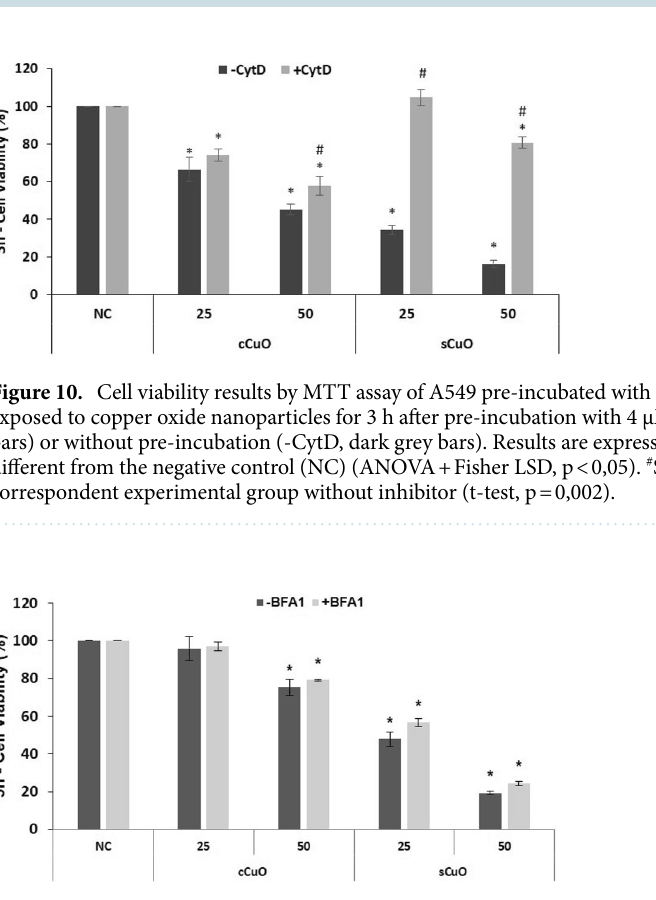
Figure 11. Cell viability results by MTT assay of A549 pre-incubated with a proton-pump inhibitor. Cells were exposed to copper oxide nanoparticles for 3 h after pre-incubation with Bafilomycin A1 (+ BafA1, light grey bars) or without pre-incubation (-BafA1, dark grey bars). Results are expressed as mean ± SD. *Significantly different from the negative control (NC) (ANOVA + Fisher LSD, p < 0,05). #Significantly different from correspondent experimental group without inhibitor (t-test, p =